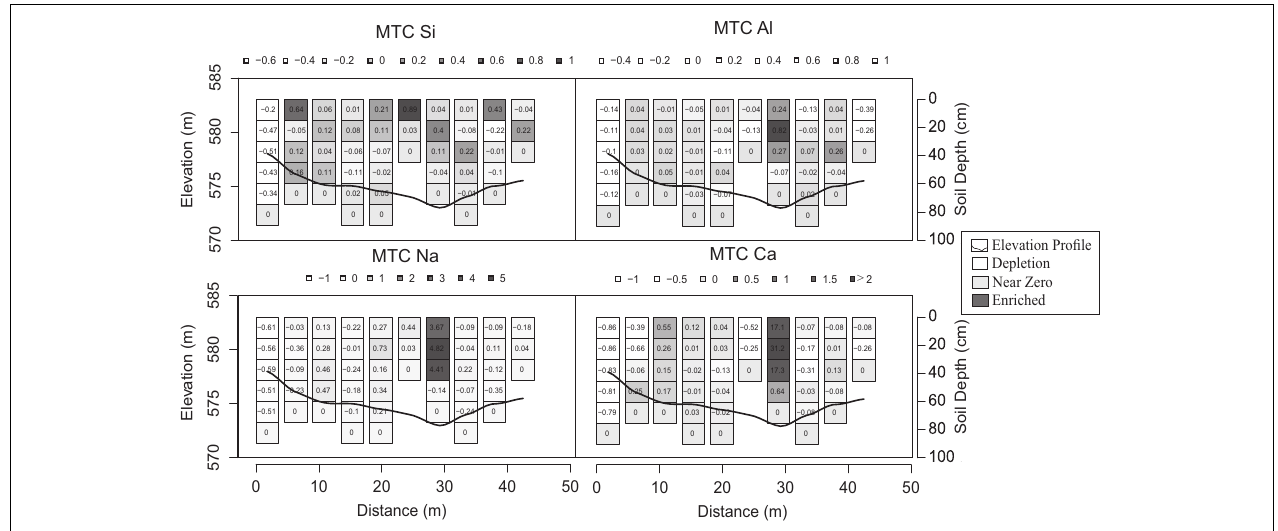
FIGURE 4 | Mass transfer coefficient (MTC) values for selected elements on the exemplified transect with the greatest relief. Upslope soils are located on each end of the elevation contour, near stream soils are located at the lowest elevation, and all other soils are defined as midslope soils. The color ramp ranges from white to black indicating depletions (white), near zero values (gray), and enrichments (black).